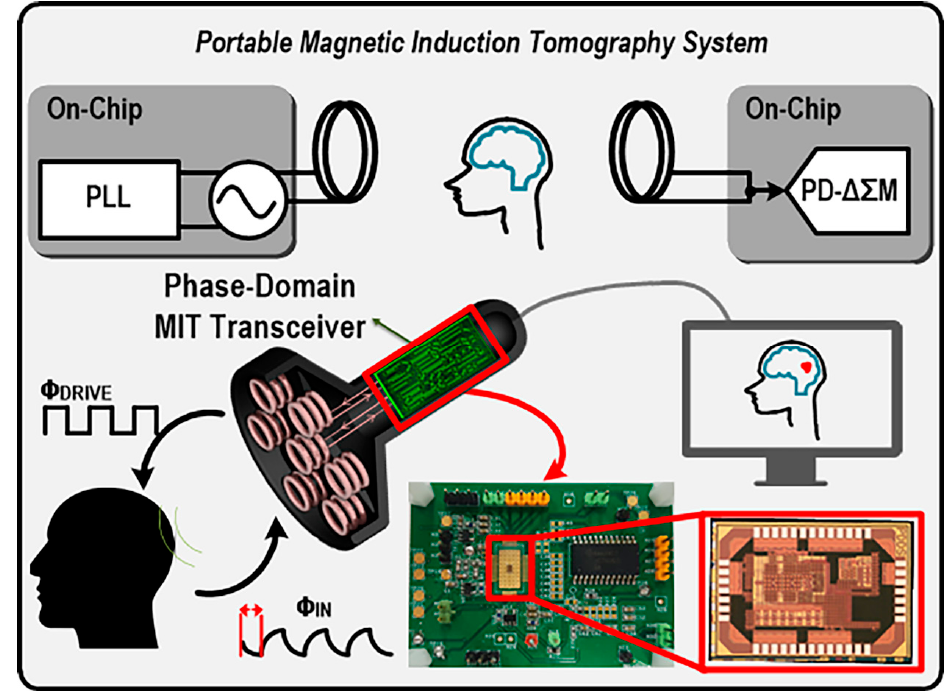
Figure 1. Conceptual diagram of a portable magnetic induction tomography (MIT) system.